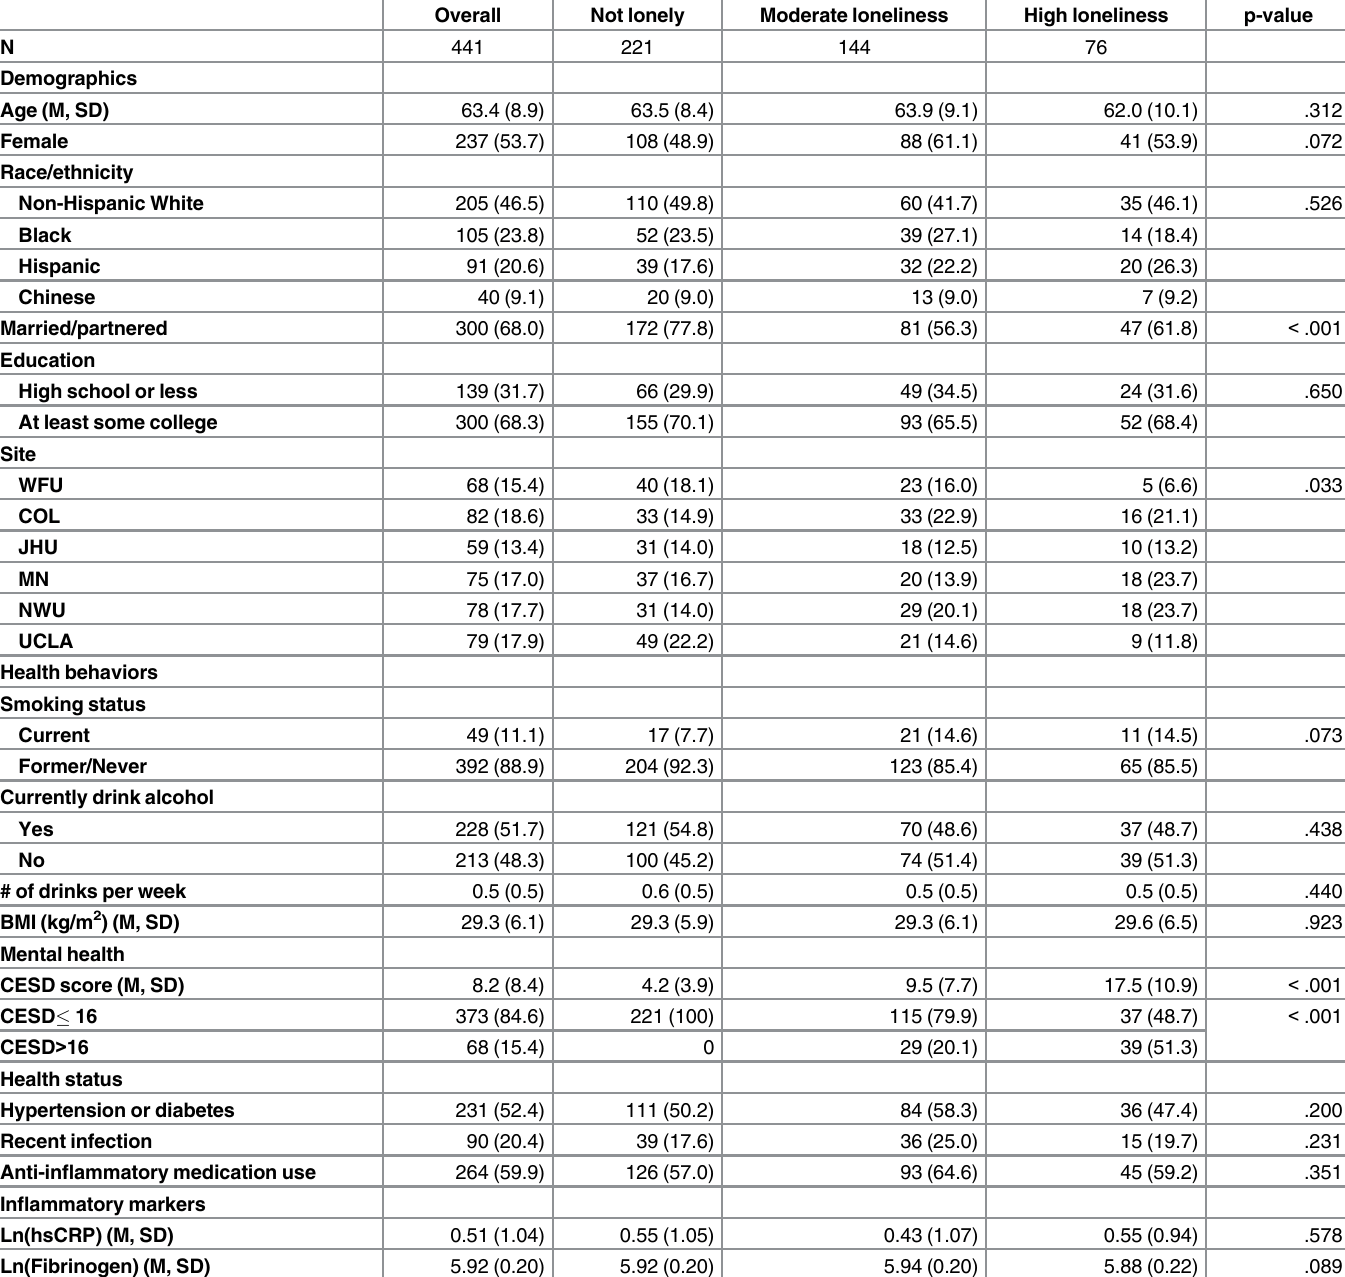
Table 1. Descriptive Characteristics by Levels of